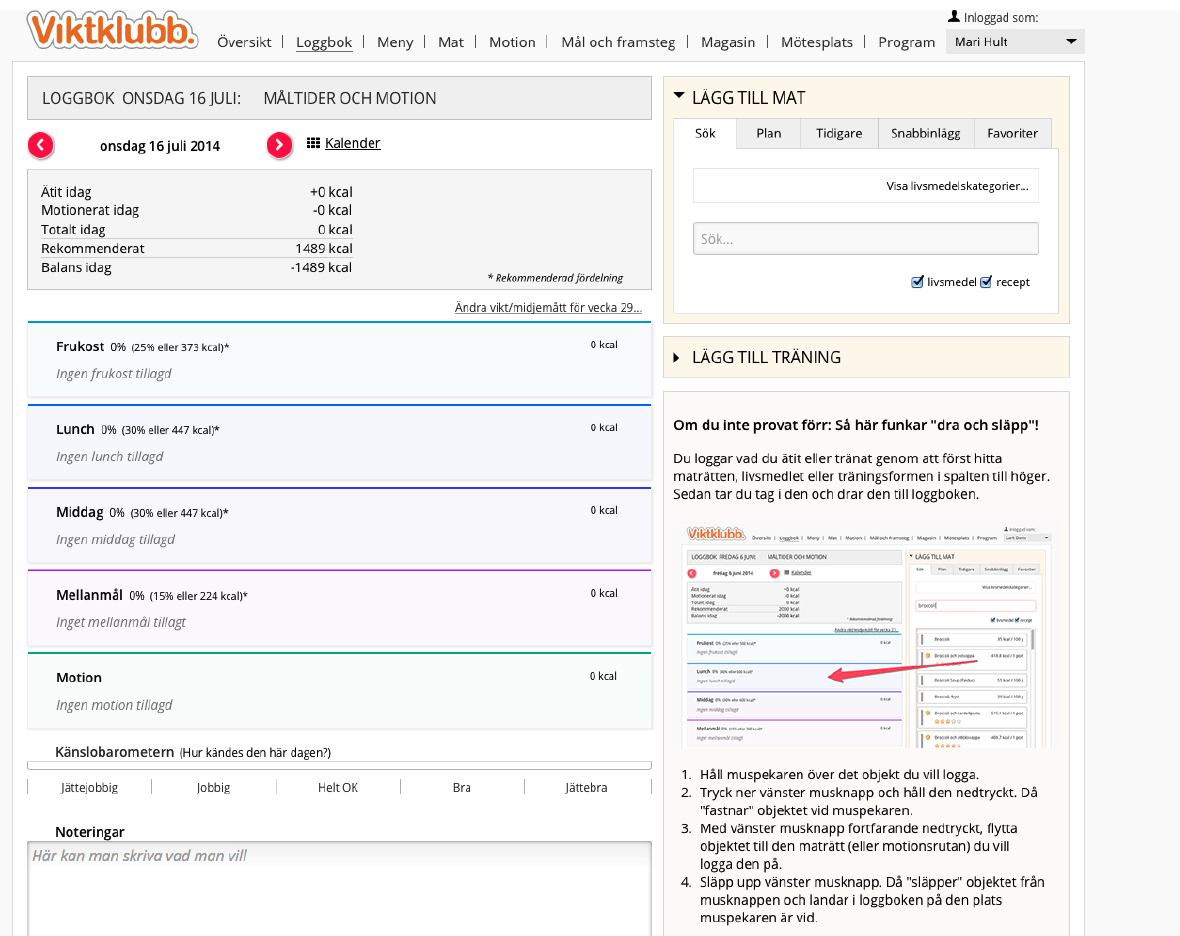
Figure 2. A diary for daily food intake, level of physical activity, and additional private comments about the day (using a drag-and-drop function). The balance between actual energy intake minus energy expended through physical activity compared to suggested energy intake is seen in the upper left